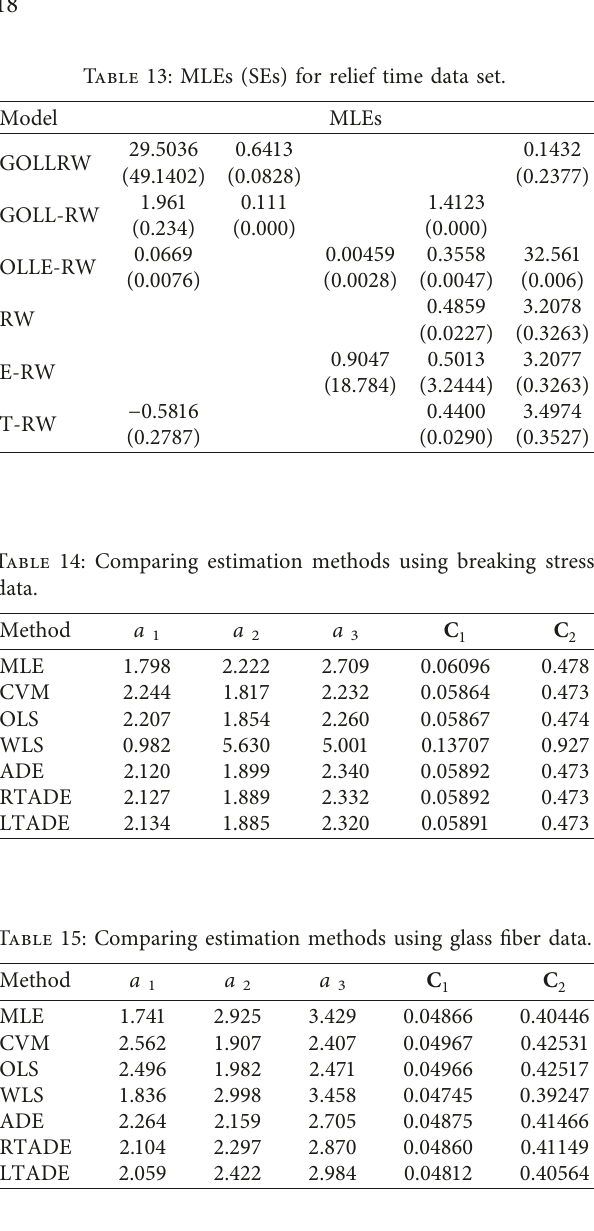
Table 16: Values of 􏽢 ρ